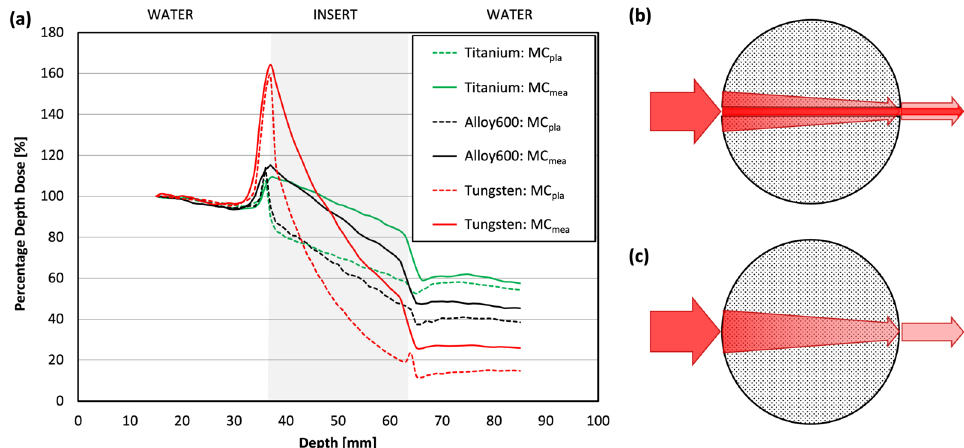
Figure 4. ( a ) The comparison of PDDs obtained from Monte Carlo simulations performed for measurement (MC mea ) and TPS conditions (MC pla ) for titanium, alloy 600, and tungsten inserts. Visualisation of the insert geometry, ( b ) two halves of the grey circle with a film gap between them (MC mea conditions) and ( c ) solid grey circle without film gap (MC pla conditions). The red arrows visible in ( b ) and ( c ) represent the radiation